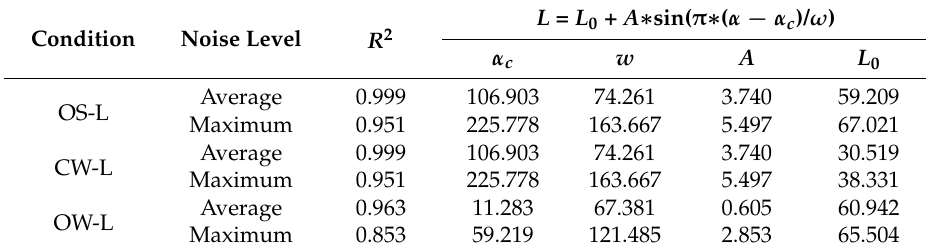
Table 9. Summary of Correlation Modeling during the aircraft landing.